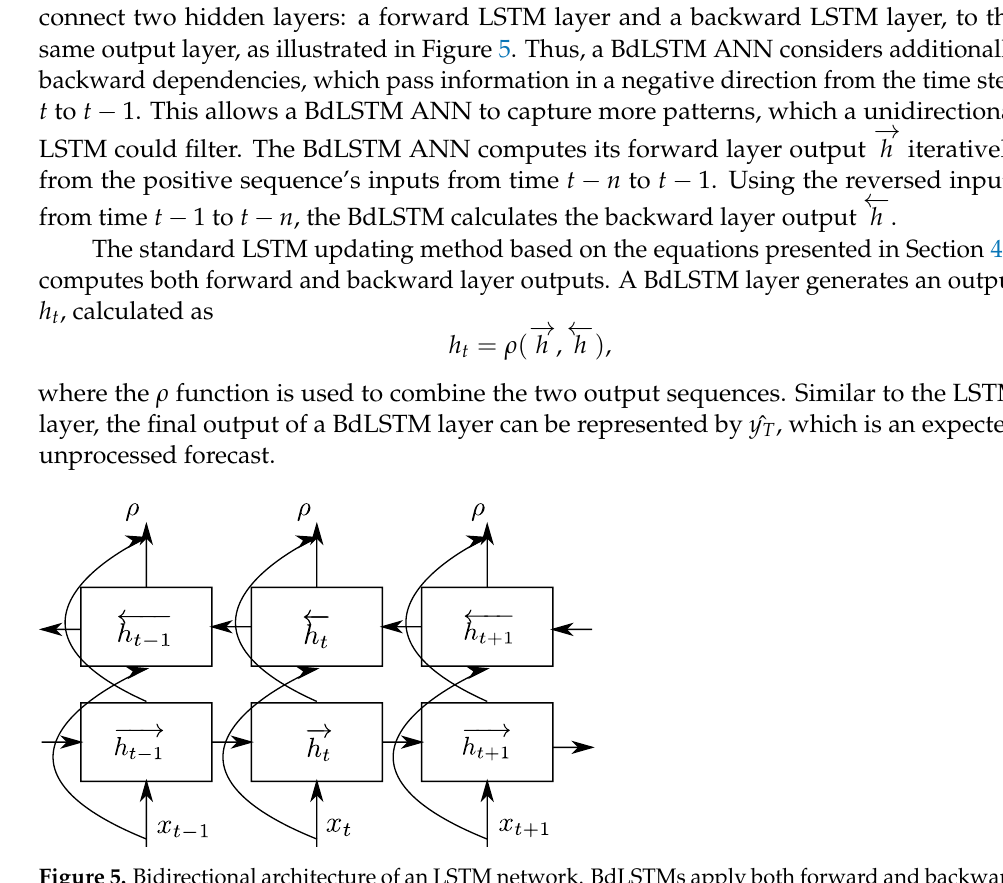
Figure 5. Bidirectional architecture of an LSTM network. BdLSTMs apply both forward and backward dependencies.